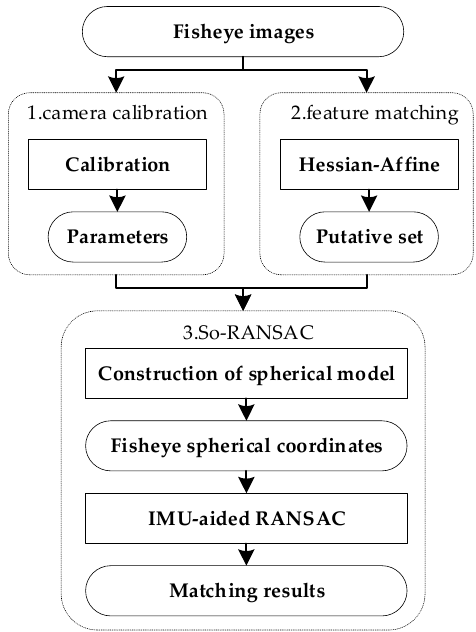
Figure 1. Overall flowchart of the fisheye image matching method.